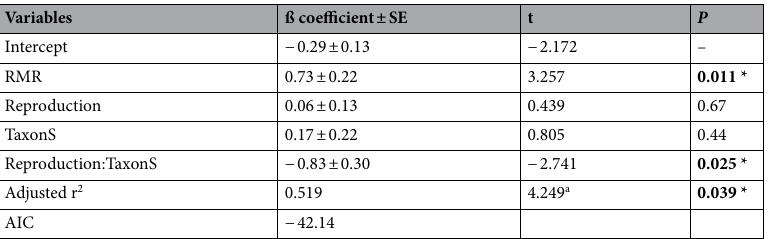
Table 4. Results of the best linear model accounting for daily energy expenditure variation. RMR and reproductive output (littermass/interbirth interval) as principal effects, with taxonomic group as an interaction term. S: strepsirhines. Variables: residuals extracted from the PGLS regression of each variable against body mass (both Ln-transformed) in a large sample of primate species (see “Methods”). Significant results are in bold. a : F-statistics (df 4 and 8) for adj-r 2